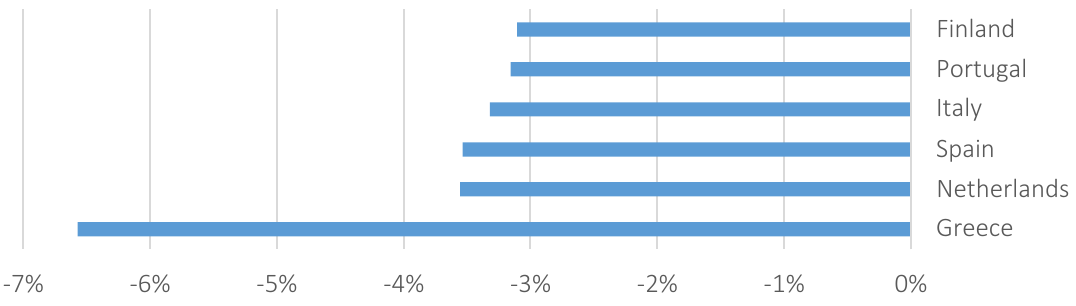
Figure 9. Predicted values of GDP gaps for the countries of the